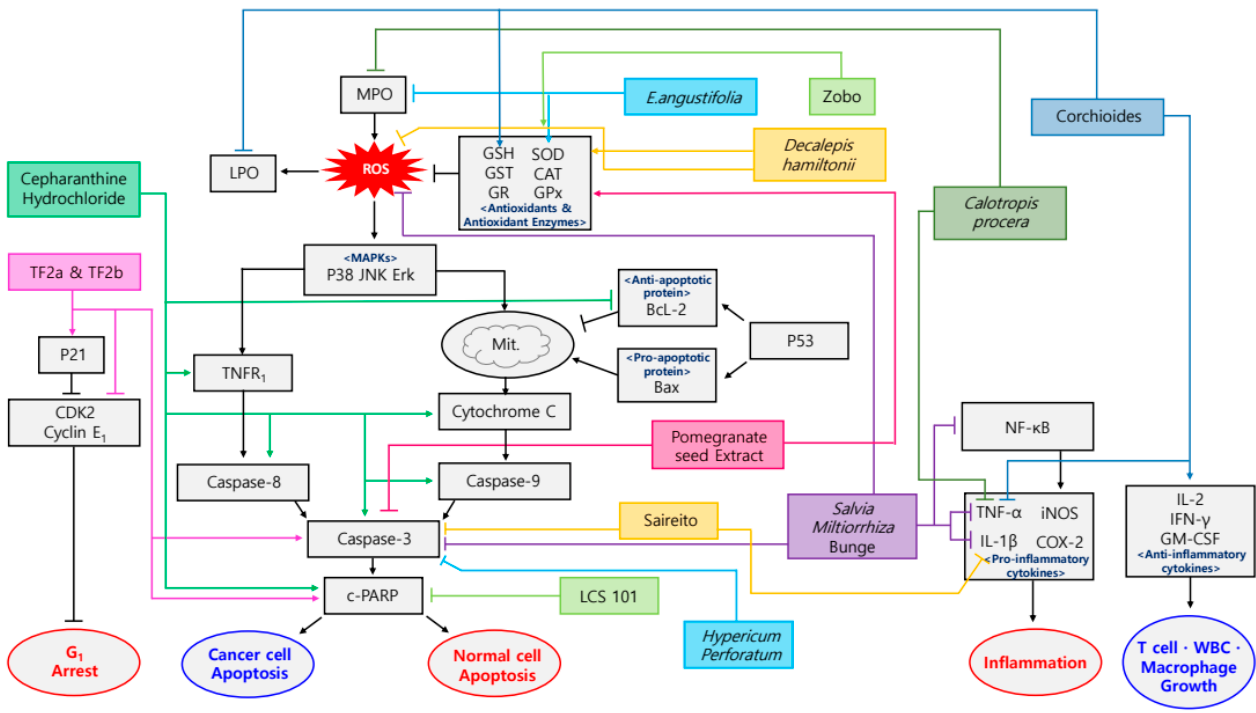
Figure 1. Schematic diagram of anti-inflammatory & antioxidant mechanisms of Plant-derived drugs in sequela of chemotherapy. TF2a, theaflavin-3-gallate; TF2b, theaflavin-3 ′ -gallate.